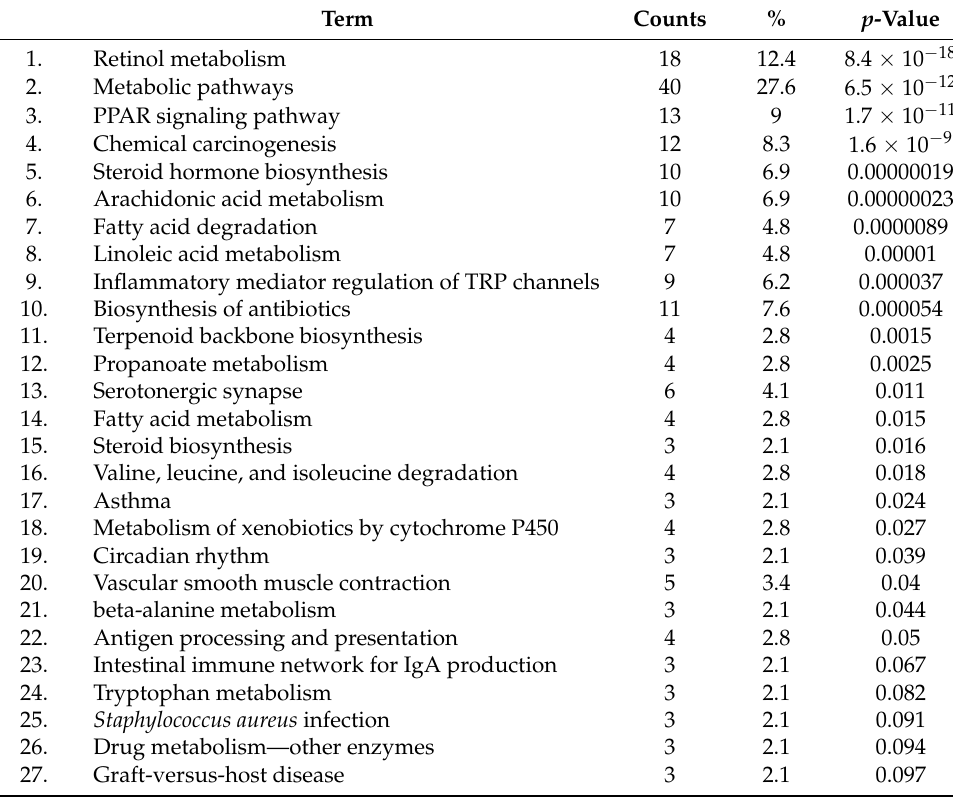
Table 4. KEGG signaling enrichment analysis between HFD-fed animals vs. control animals by the DAVID Bioinformatics tool.